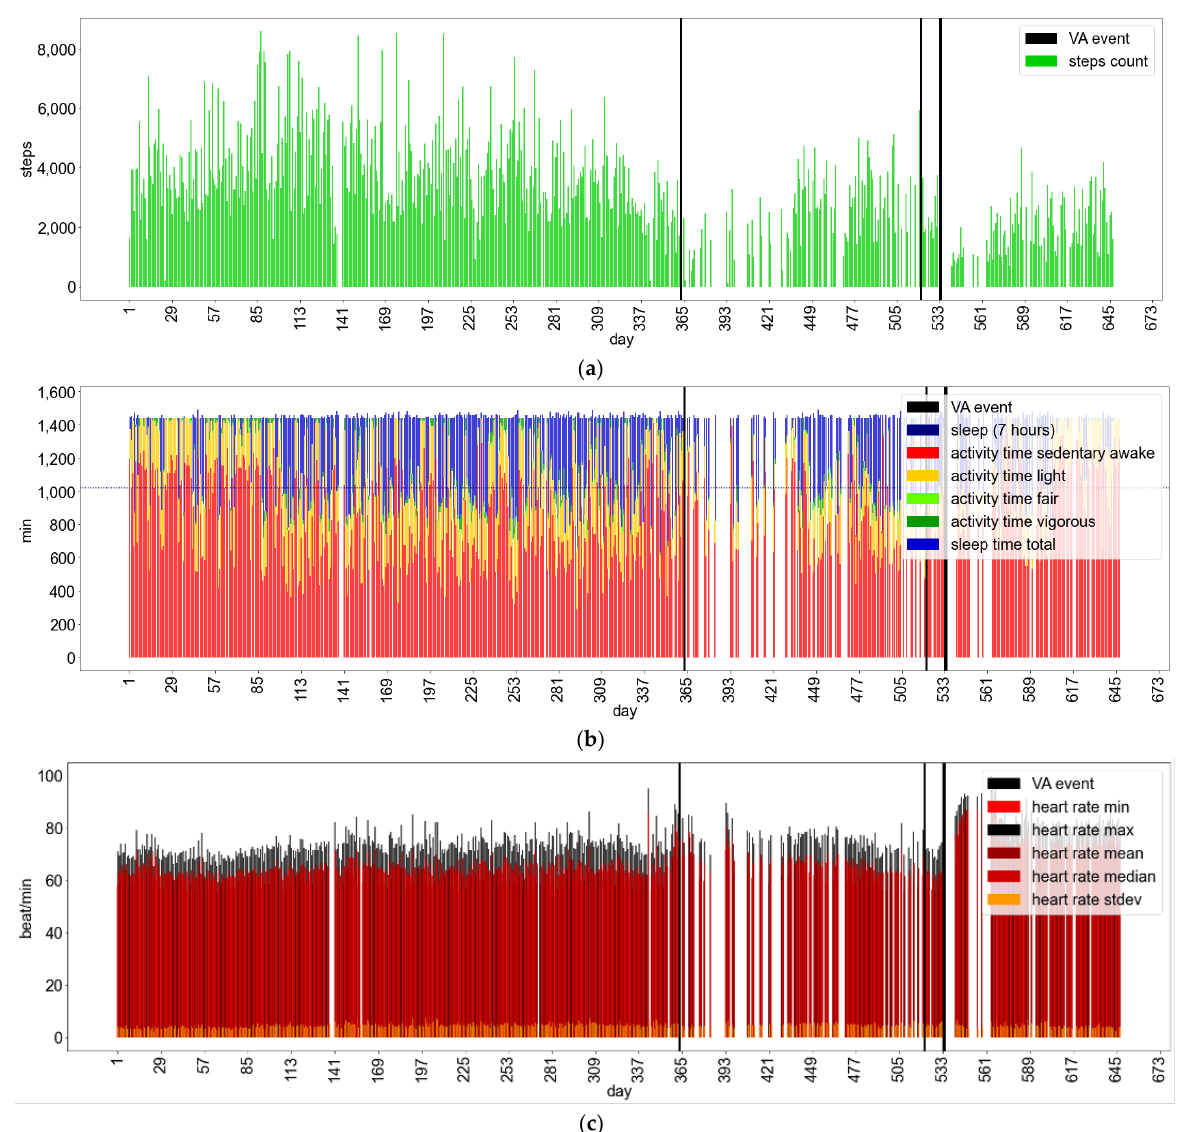
Figure A3. Daily life behaviors (bars) and VA events (strokes) observed in the Fitbit monitoring time interval for Patient 12; ( a ) steps; ( b ) physical activity — sedentary awake includes non-measured and measured-as-sedentary durations excluding measured sleep — and sleep duration; ( c ) heart rate. Patient 18 (male, 47-year-old, device type ICD) was monitored over a period of 993 days (Table A2). He experienced 20 VA events, nine of type VT, six of type VT1, and five of type VF-VT (Table A1) over a period of 972 days (Table A2). He wore the Fitbit for 326